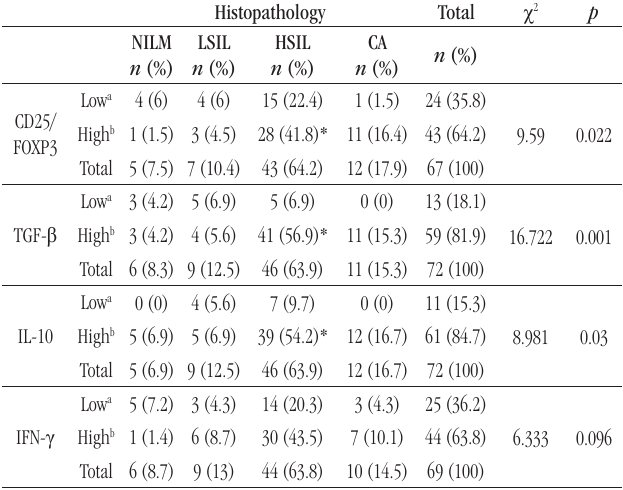
taBLE 3 − Distribution of histopathological findings according to the co-expression of CD25/FOXP3 and the expression of TGF- β , IL-10 and IFN- γ